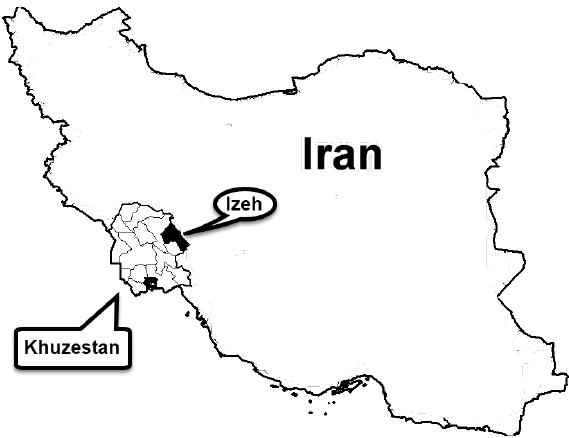
Figure 1. Area of This Research in Izeh County (Khuzestan province) in the Southwest of Iran (2014-2019).